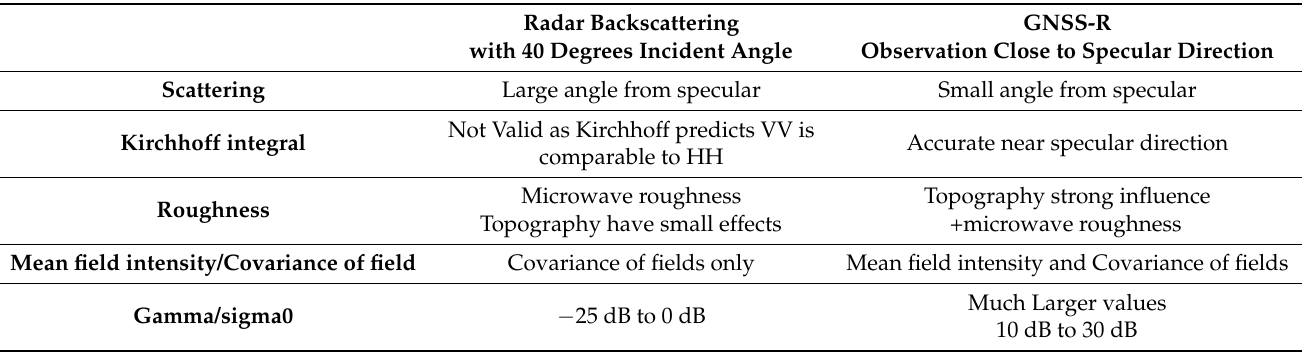
Table 4. Comparison between radar backscattering and